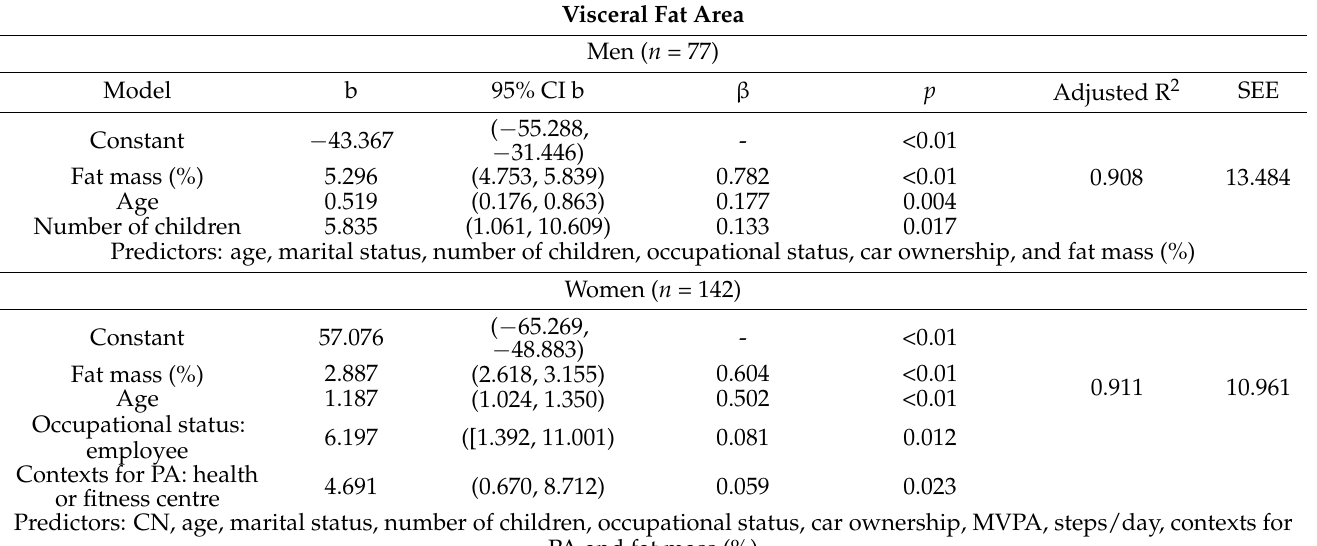
Table 6. Multiple linear regressions developed in both genders for body